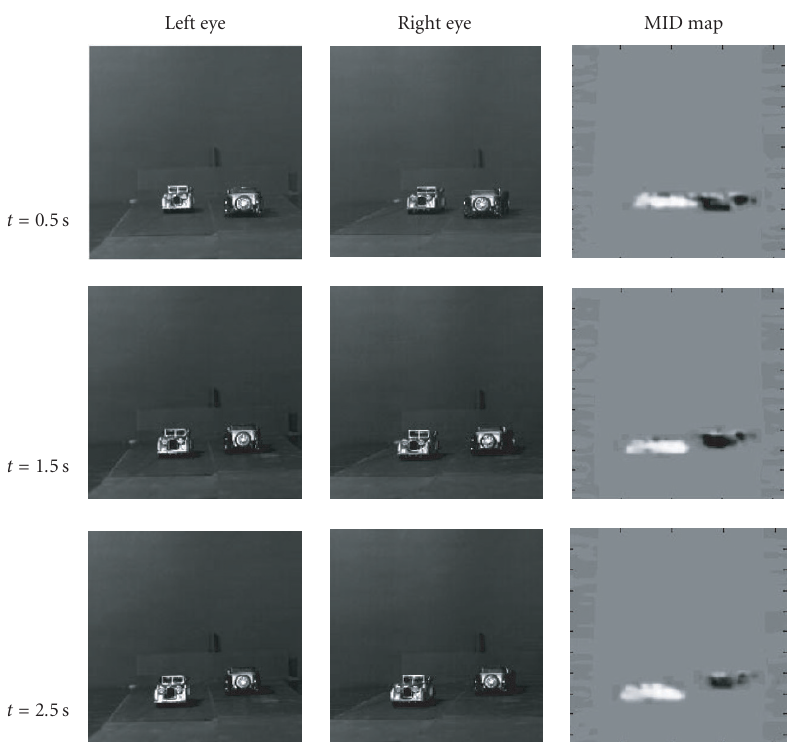
Figure 9: Experimental results on a natural scene. Two toy cars are moving in opposite directions with respect to the observer. Left and right frames at three di ff erent times are shown. The gray levels in the MID maps code the MID of the two cars: the lighter gray blob represents the car moving toward the observer, whereas the darker gray blob represents the car moving away. The background gray level represents points discarded according to the confidence measure. The few still present error points do not impair the interpretation of the MID